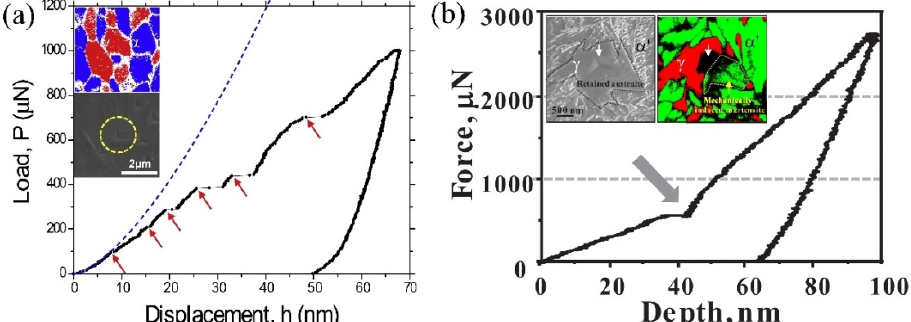
Figure 4. ( a ) Engineering stress–strain curve of austenite micro-pillar compressed along [111] crystal orientation. ( b ) The corresponding SEM micrograph of the austenite micro-pillar after the compres- sion test. The inset in ( b ) is a tetrahedron indicating the orientation of the {111} slip plane. ( c ) TEM bright-field image displaying the formation of intensive dislocations in the pillar after compression test. ( d ) Magnified view of the rectangle in ( e ) showing the perfect dislocations along the (-1 -1 1) slip plane. € TEM BF image of the same region with different beam -direction [81]. Reprinted with permission from ref. [81]. Copyright 2017, Elsevier.